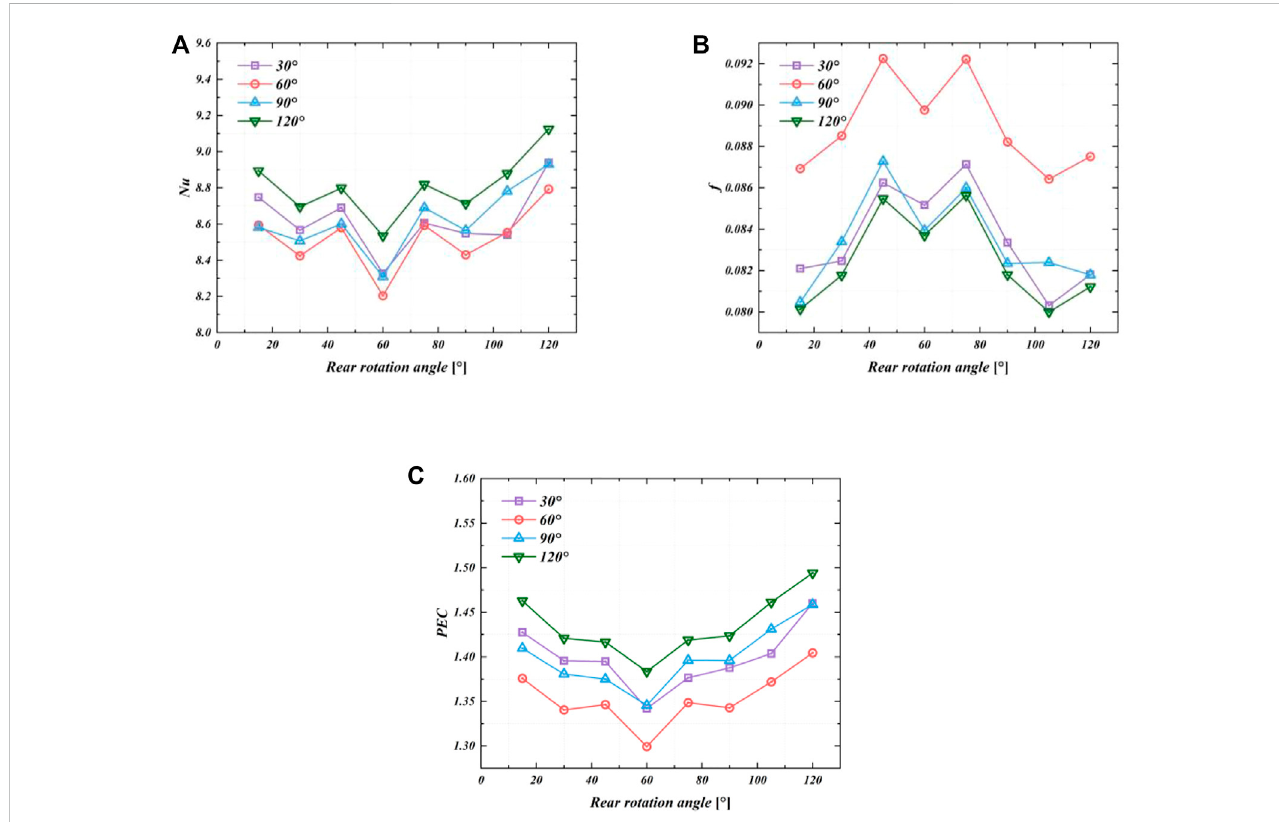
FIGURE 12 Effects of rear rotation angle on cooling performance (Re = 663): (A) Nu; (B) f ; (C)